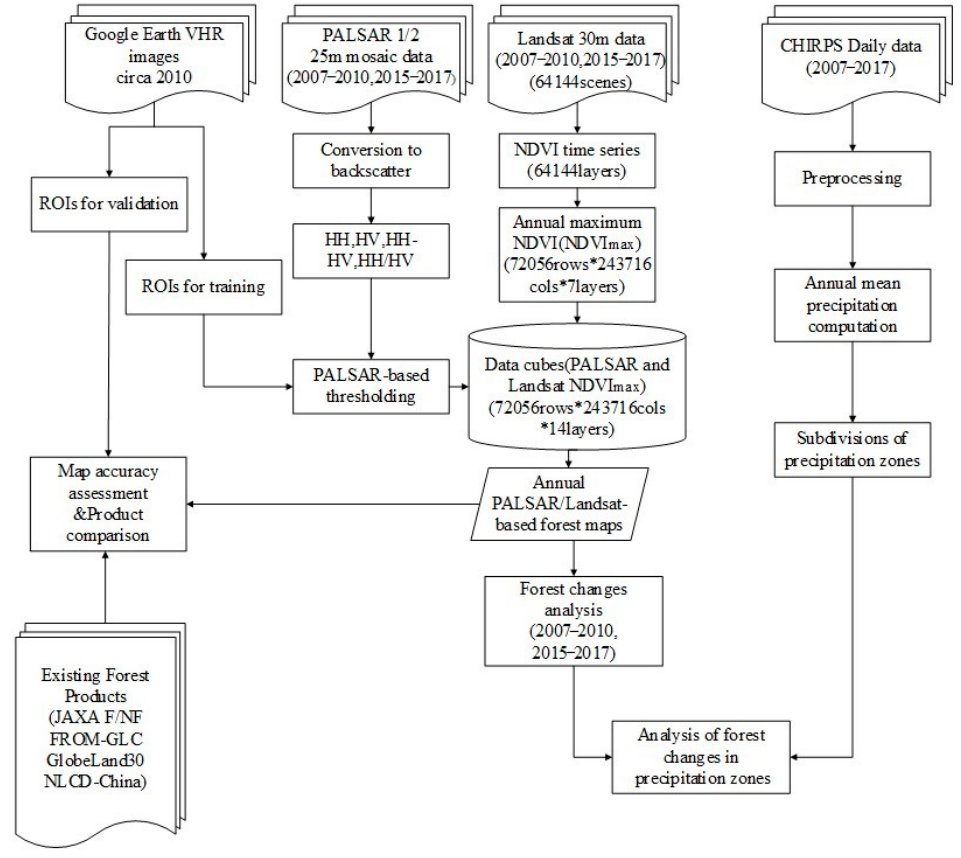
Figure 3. Summarized workflow for investigating the spatial-temporal changes of forests in different precipitation zones in northern China.